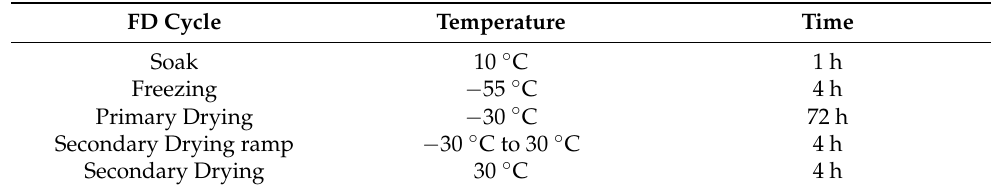
Table 3. Freeze-drying cycle conditions.